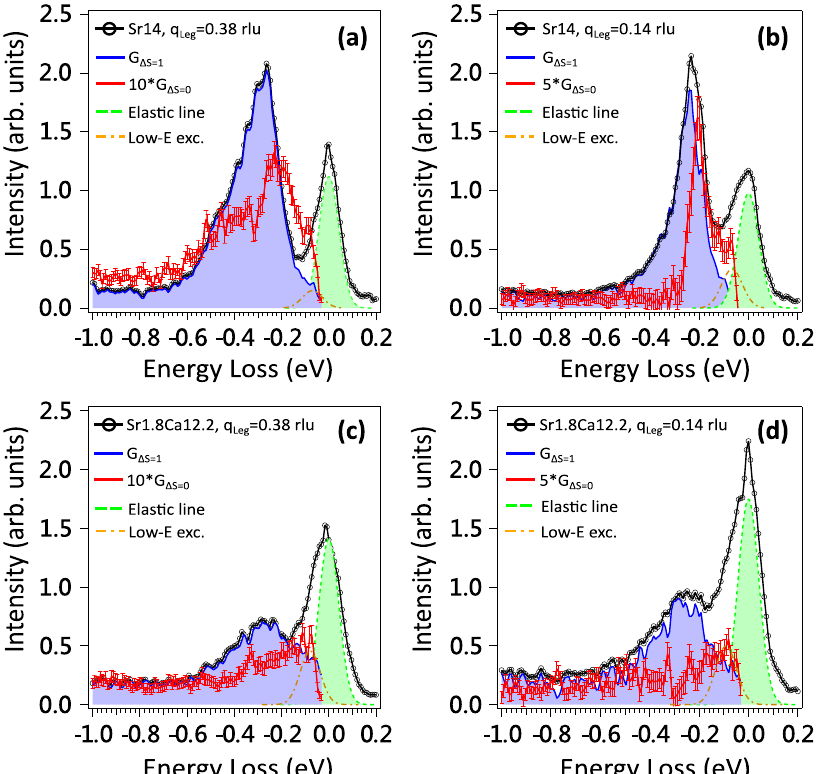
Fig. 4 Disentangled spin and charge dynamics by polarization-resolved RIXS. Cu L 3 -edge RIXS spectra with Δ S = 1 (blue-shadowed) and Δ S = 0 (red line) channels disentangled for ( a – b ) Sr14 and ( c – d ) Sr1.8Ca12.2 taken at q Experimental data shown here are taken with π polarization in grazing emission geometry. We remind the reader that the RIXS intensity I ε ; q ð Þ can be expressed as combination of Δ S = 1 and Δ S = 0 dynamical structure factors G Δ S ; ε ; q ; ω ð Þ multiplied by form factors F Δ S ; ε ; q ð Þ of the scattering processes 22,46,60